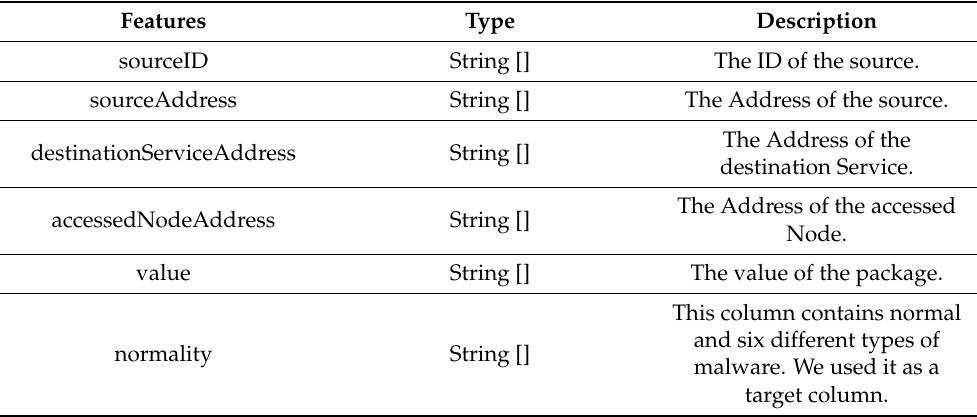
Figure 10. Top 5 features that has a strong relationship with the target variable. Table 3. DS2OS dataset features after Feature Selection.